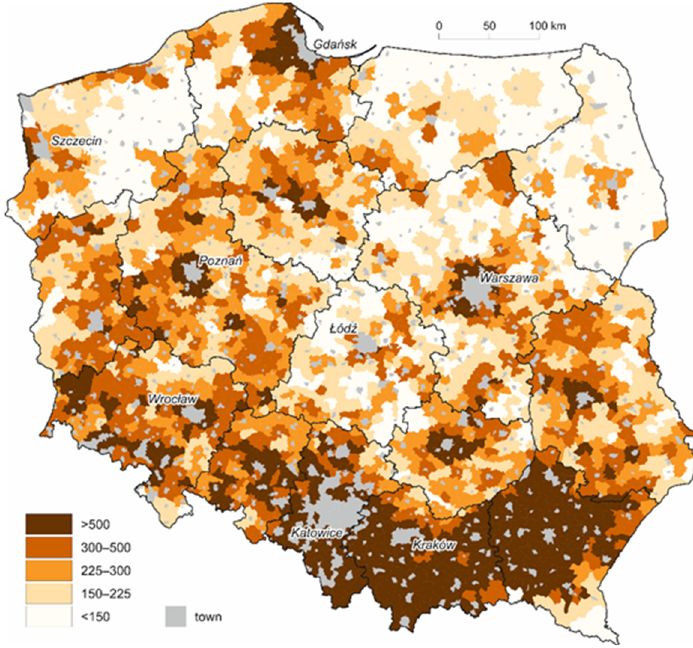
Figure 2. Average size of a village in the commune in 2018. Source: Own study based on BDL GUS data.